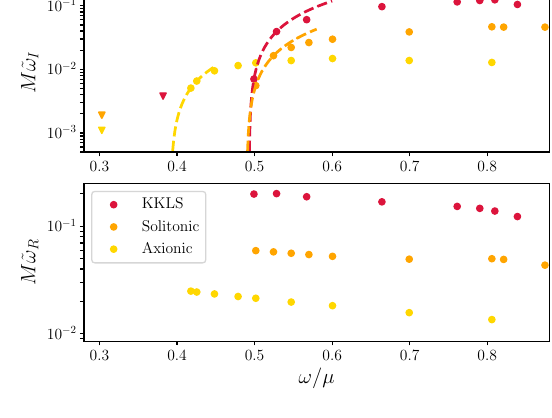
Fig. 19 Mode analysis of rotating BSs. The imaginary (top) and real (bottom) frequency components of the m ¼ 2 mode as a function of the BS frequency x = l for families of rotating BS solutions with k ¼ 1 and three different potentials. The NAI is present for all the potential (i.e., M ~ x I [ 0) above a critical frequency. Reproduced with